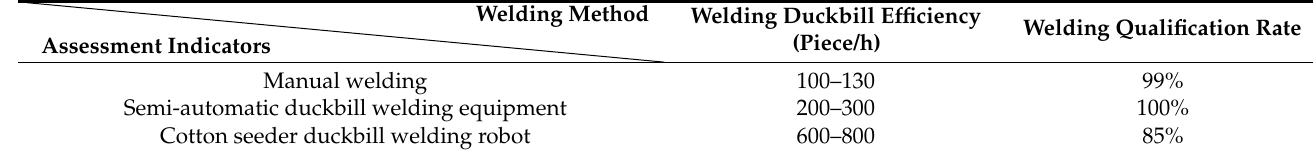
Table 4. The cotton seeder duckbill welding robot performance